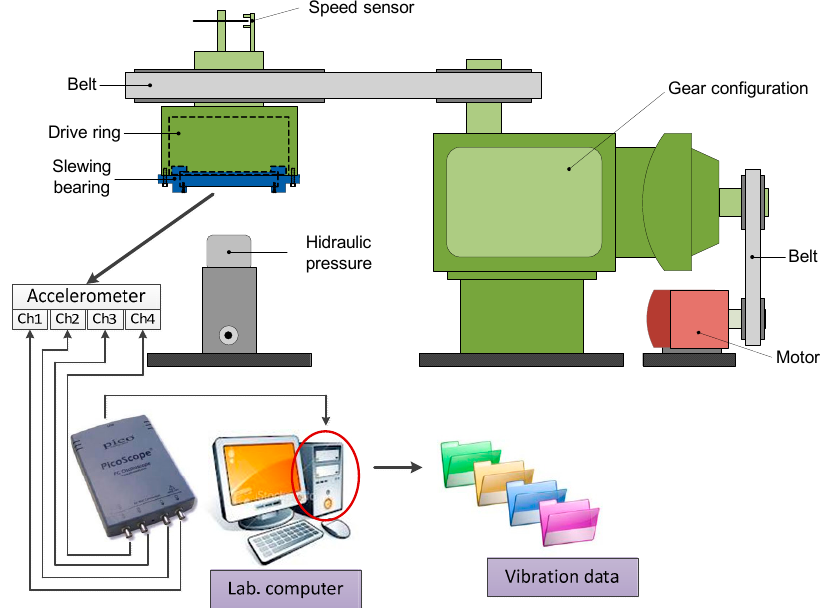
Figure 2. Schematic diagram of slew bearing test-rig and data acquisition flow process.